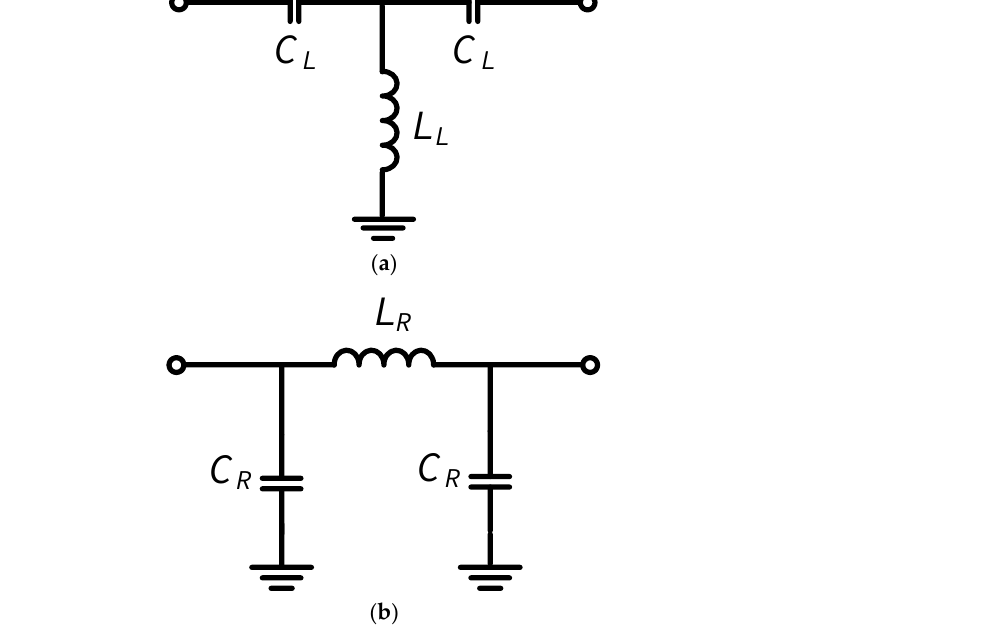
Figure 4. Schematic of ( a ) left-handed and ( b ) right-handed transmission lines. The inductor and capacitor values of the lumped transmission lines are related, as shown below.